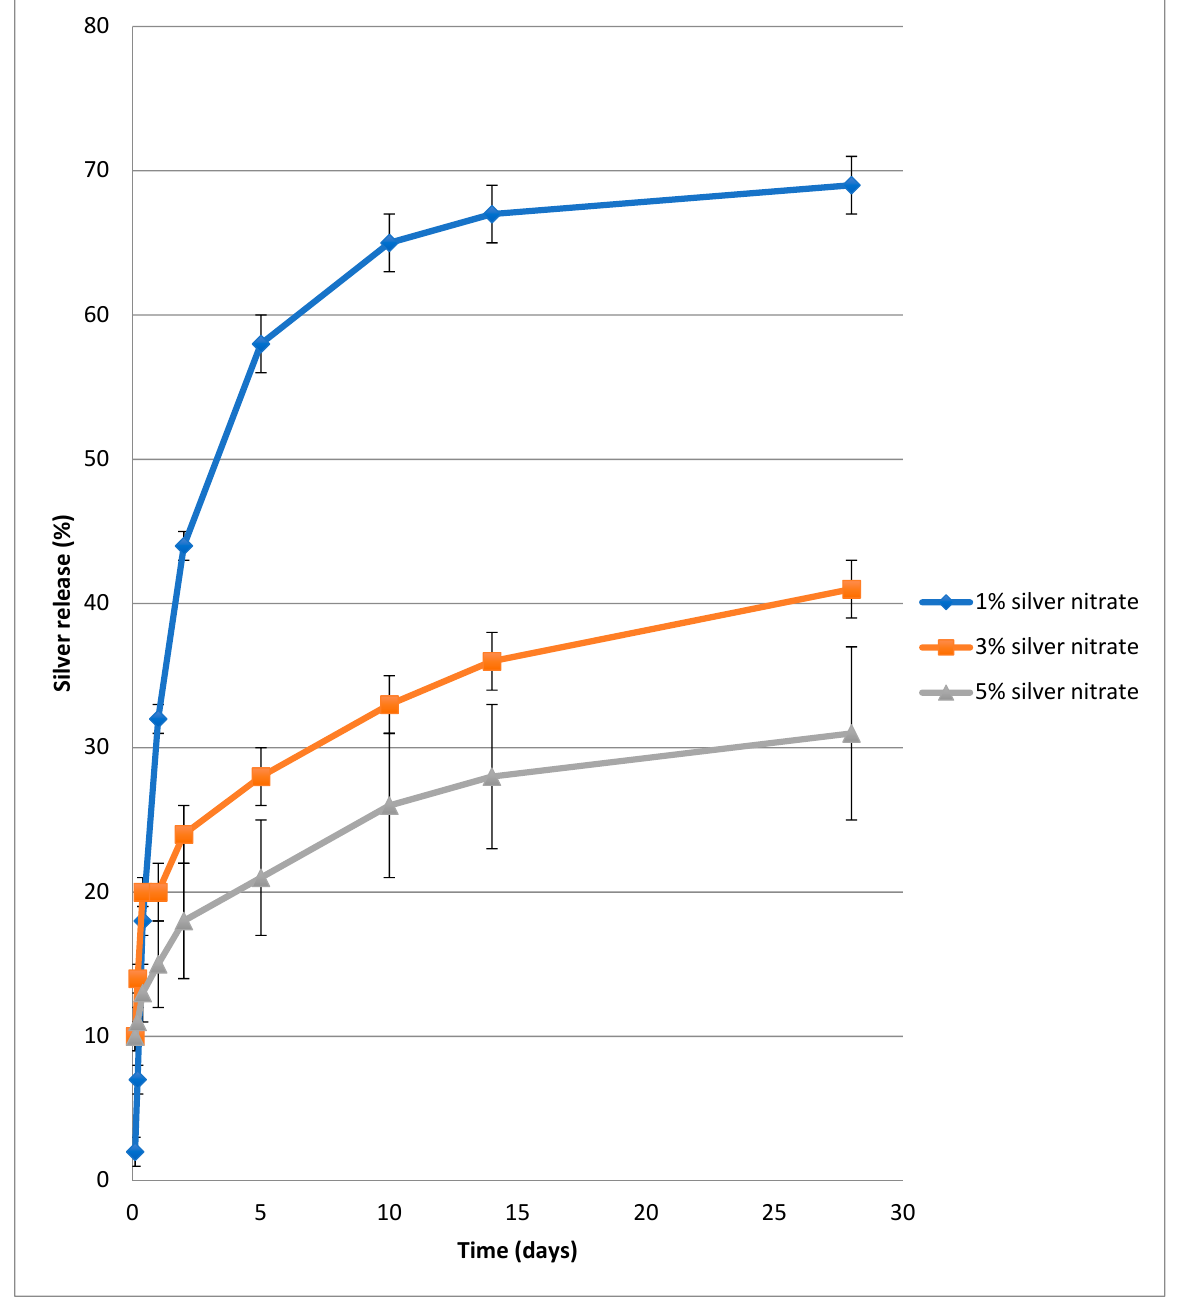
Figure 6. In vitro release of silver from PVA/silver nitrate films heated at 140 °C for 90 m and then immersed in water as a function of silver content.